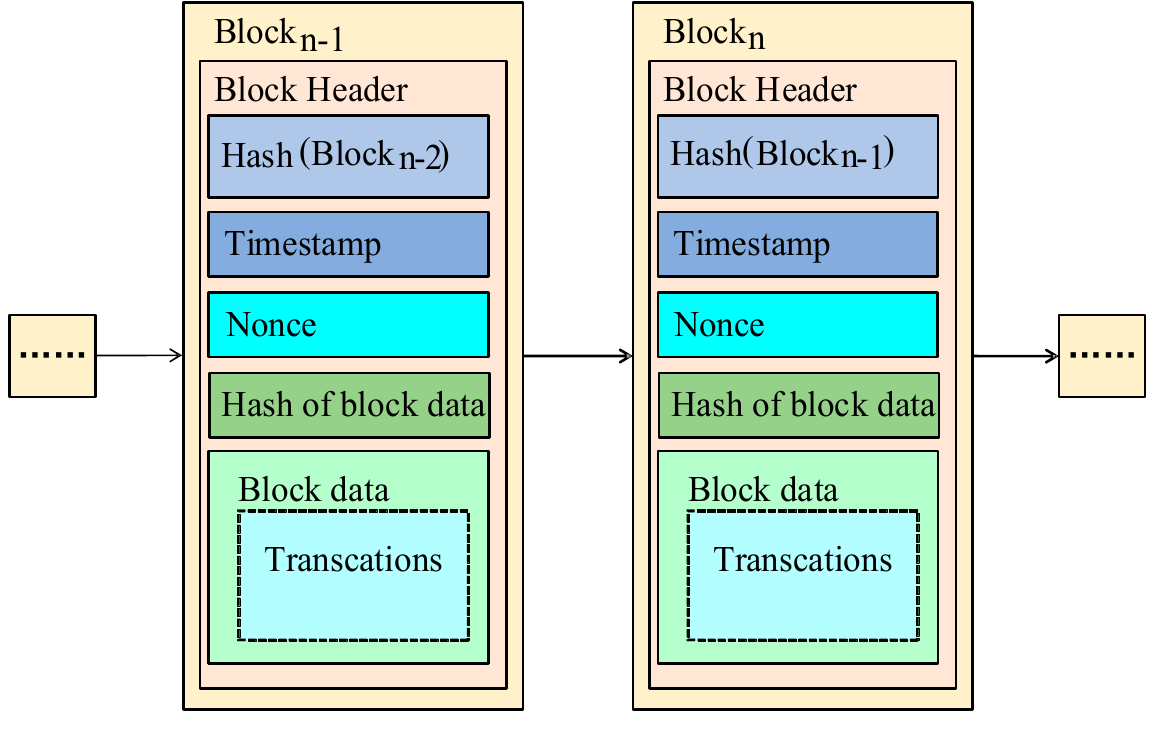
Figure 1. Block structure.